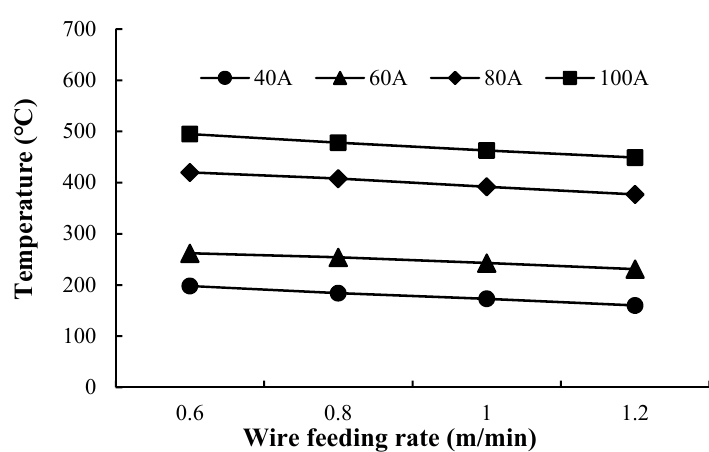
Figure 5. The relationships between wire feeding rate, current and wire temperature.